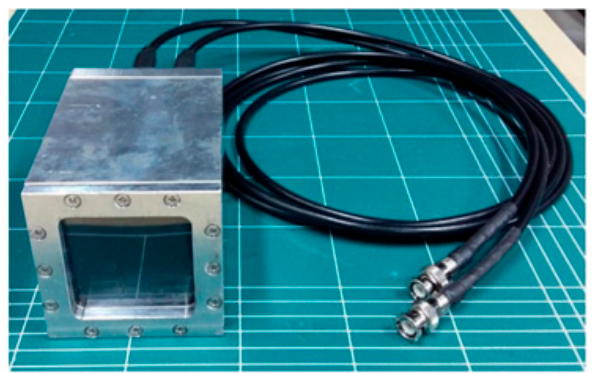
Figure 25. SiPM-CaF 2 :Eu prototype detector [92].